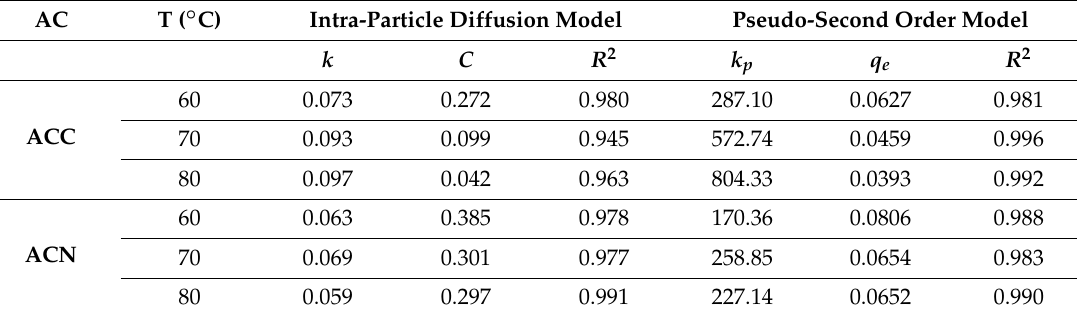
Table 2. Constants and R 2 values for equations used in modeling the adsorption kinetics. AC T (°C)